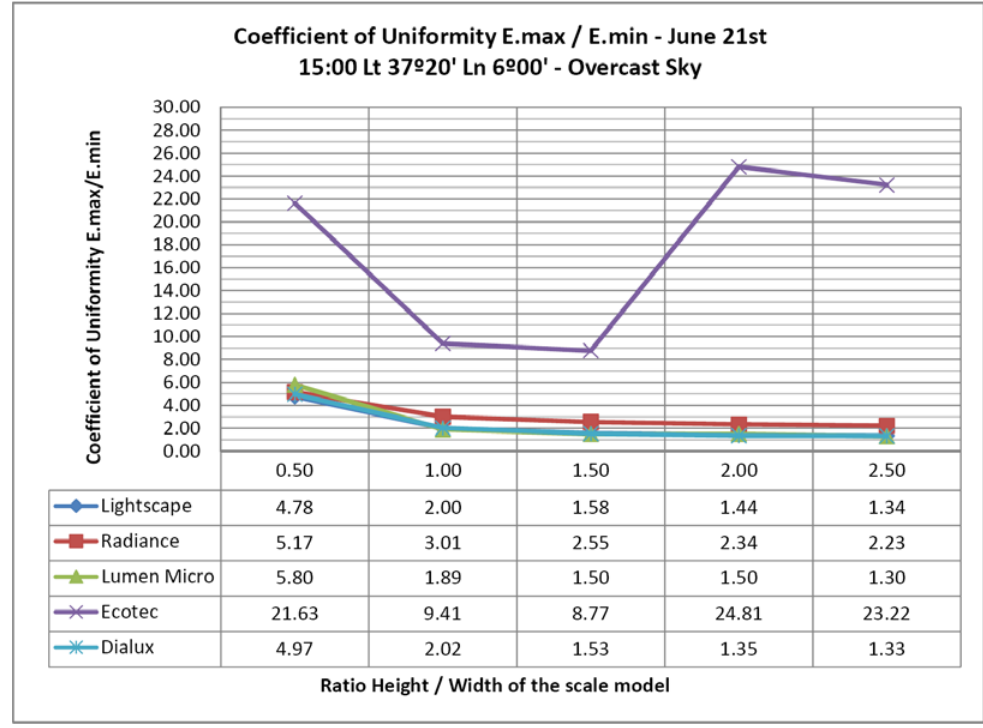
Figure 6. Coefficients of Uniformity (Max/Min illuminance levels) varying the height of the model from 1.5 m to 7.5 m. June 21st at 15:00, overcast